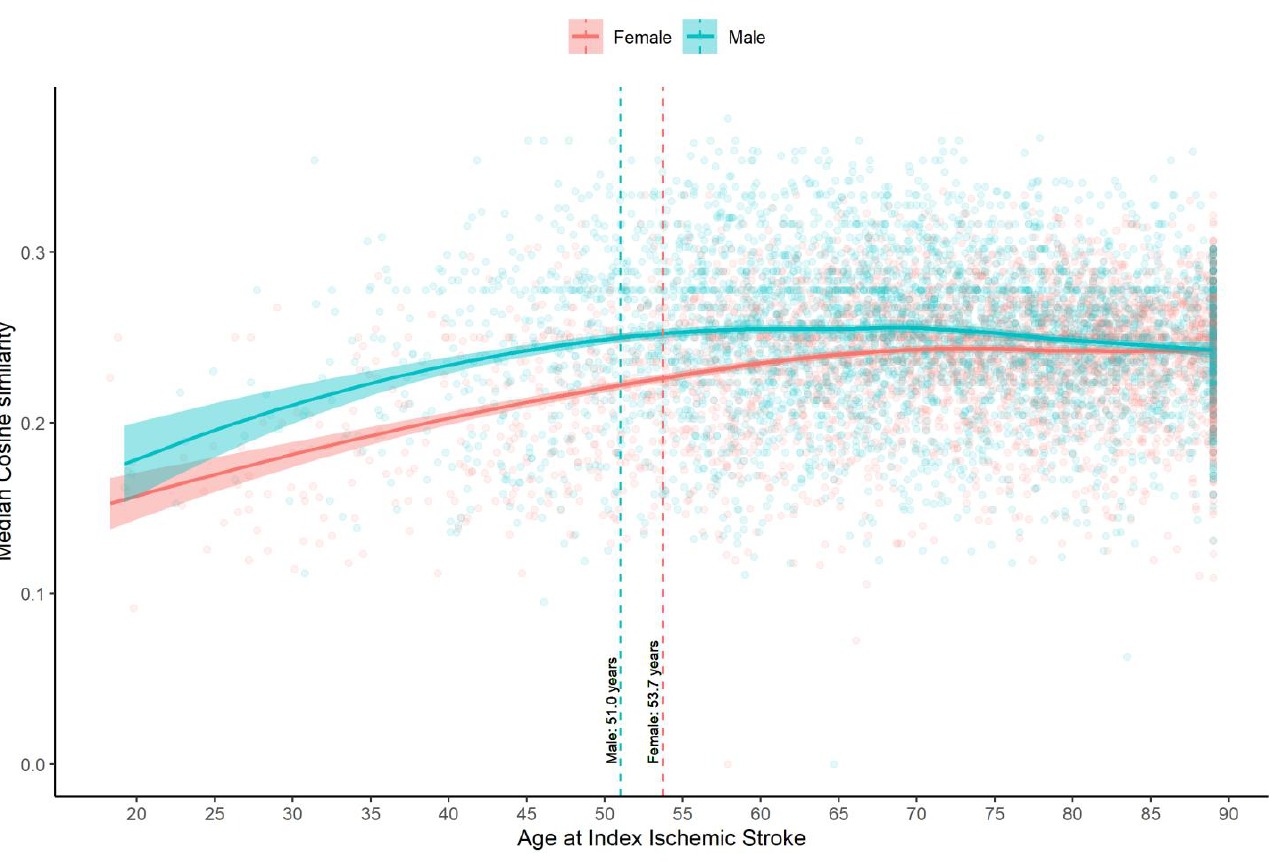
Figure 2. Scatter plot of median cosine similarity and age at index ischemic stroke date with a smoothed line, using loess regression.